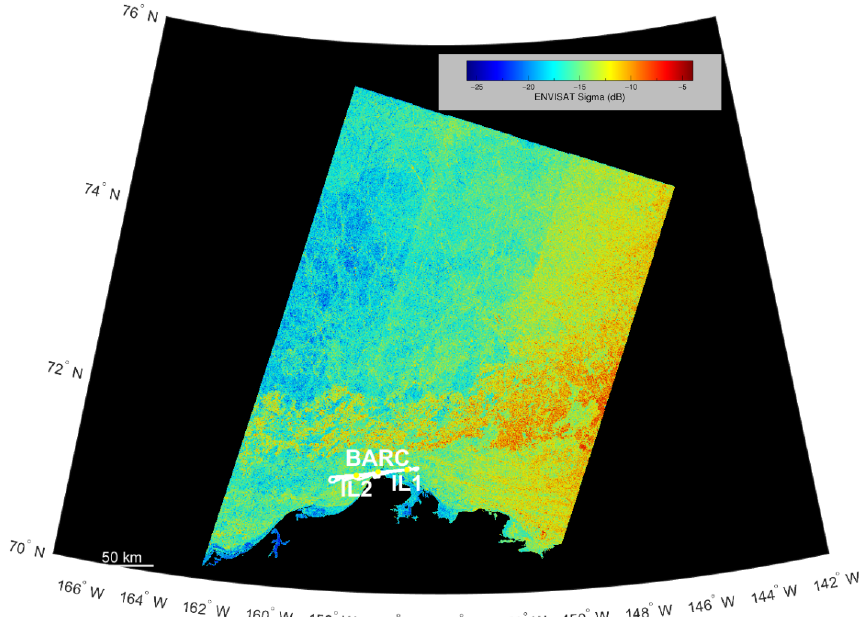
Figure 2. Sea ice imagery from Envisat Advanced Synthetic Aperture Radar (ASAR) backscatter data (Sigma in dB). Flight track and measurement locations include Barrow Arctic Research Consortium (BARC) building, Icelander 1 (IL1), and Icelander 2 (IL2). Multi-year ice is shown in darker red, and first-year ice is shown in orange to green and blue